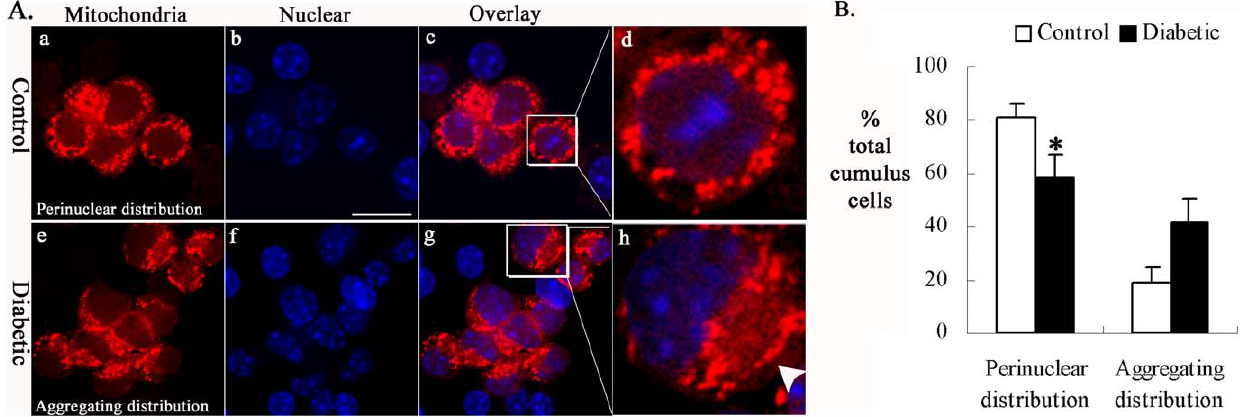
Figure 3. Mitochondrial distribution was disrupted in cumulus cells of diabetic mice. Cumulus-oocyte complexes collected from control and diabetic mice were labeled with MitoTracker Red to visualize mitochondrial localization and costained with DAPI to visualize nuclei. Representative confocal sections of cumulus cells are shown. (A) Mitochondria of most cumulus cells from control mice show perinuclear distribution pattern (a–d). Notably, in cumulus cells from diabetic mice, aggregating distribution pattern of mitochondria was readily observed (e–h; arrowhead). (B) Quantification of cumulus cells with each mitochondrial distribution pattern from control and diabetic mice. Data are expressed as mean percentage 6 SD from three independent experiments in which at least 200 cells were analyzed. * p , 0.05 vs control. Scale bar: 20 m m.